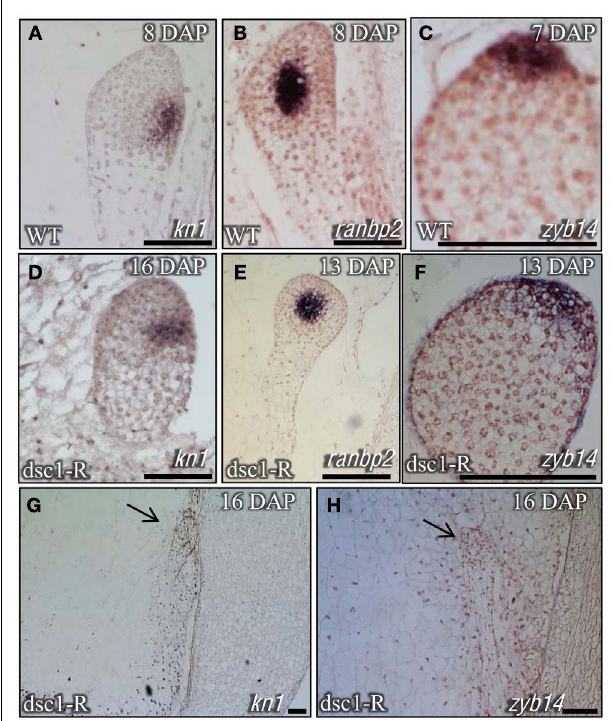
FIGURE 3 |Transcriptional markers illustrate that dscl-R mutants develop a shoot meristem, vasculature, and initiate lateral organs. Severe dscl-R mutants are not able to maintain a meristem and lateral organ initiation. Sagittal sections of (A–C) non-mutant and (D–H) dscl-R mutant embryos probed with knotted 1 ( kn1 ; A,D,G ), ran binding protein2 (ranbp2 ; B,E ), and Zea mays yabby14 ( zyb14 ; C,F,H ). (A–F) Non-mutant and dscl-R mutant embryos were harvested at different time-points to show the same stage of embryo development. DAP, days after pollination. Scale bars represent